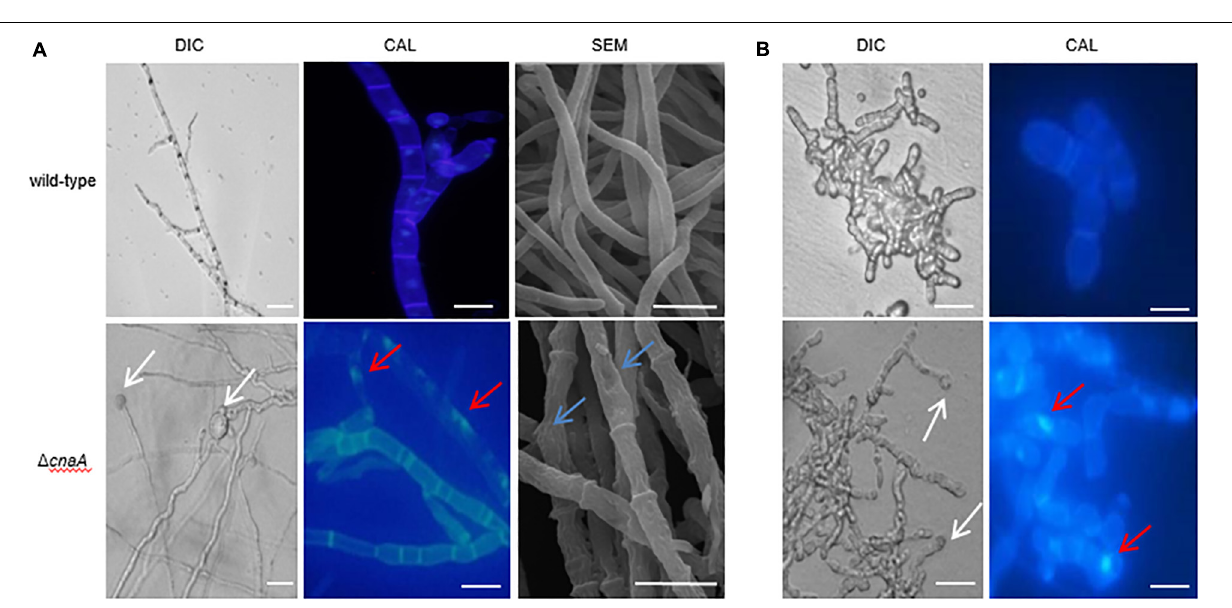
Frontiers in Microbiology |